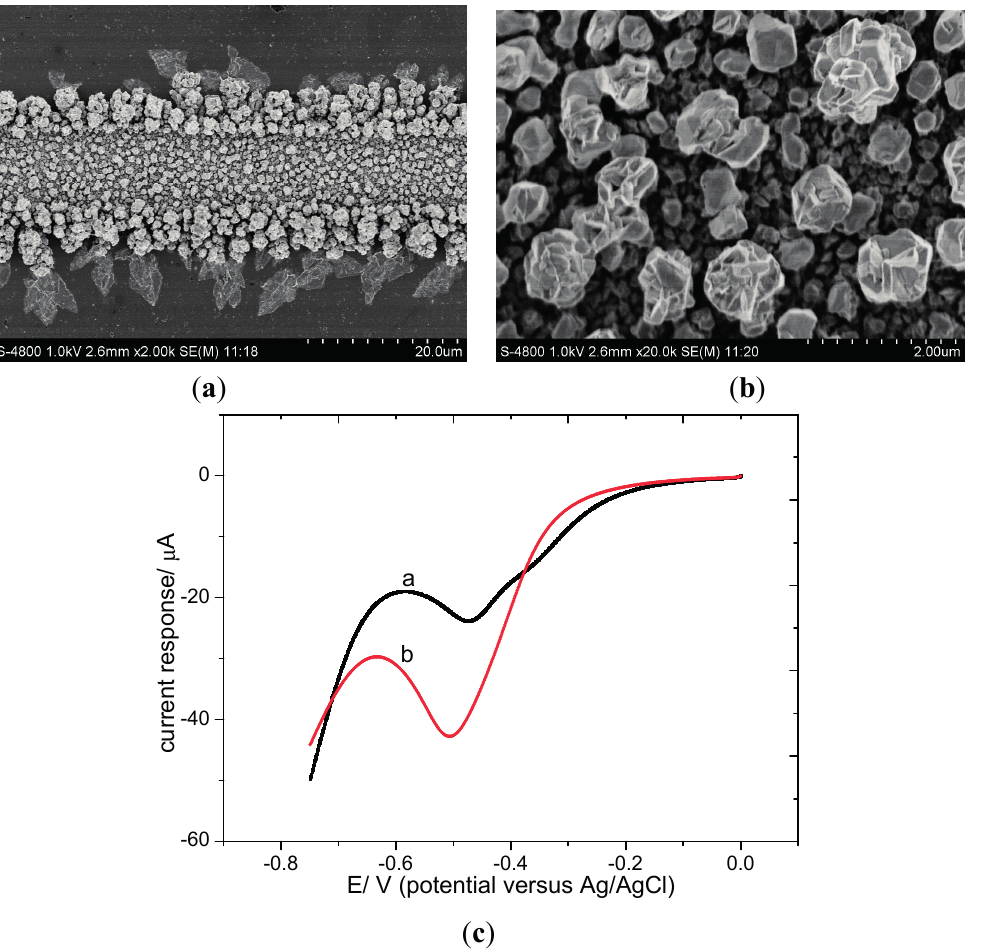
Figure 2. ( a ) SEM image of a single band of the Pd-Sn modified electrode (×2000); ( b ) SEM image of the surface of the Pd-Sn modified electrode (×20,000); ( c ) linear sweep voltammograms of Pd-Sn modified electrode testing in 0.01 M HClO 4 respectively containing 0 mg/L (as N) KNO 3 (curve a) and 5 mg/L (as N) KNO 3 (curve